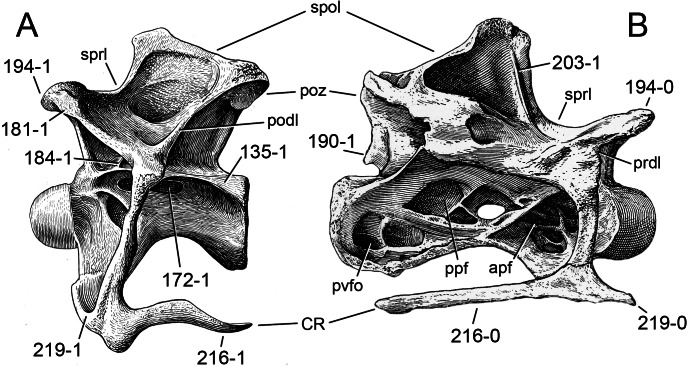
Cervical vertebra 11 of diplodocids.Cervical vertebra 11 of Apatosaurus louisae CM 3018 (A; modified from Gilmore, 1936) and Diplodocus carnegii CM 84 (B; modified from Hatcher, 1901) in left (A) and right (B) lateral view. Note the posteriorly extending posterior centrodiapophyseal lamina in Apatosaurus (A; C135-1), the anteriorly restricted pneumatic foramen typical for most apatosaurs (A; C172-1), the pre-epipophysis (A; C181-1), the subdivided prezygapophyseal centrodiapophyseal fossa, characterizing A. louisae (A; C184-1), the posteriorly expanded interpostzygapophyseal lamina of Diplodocus (B; C190-1), the posteriorly restricted prezygapophysis of A. louisae (A; C194-1), compared to the state in Diplodocus, where it reaches the anterior edge of the condyle (B; C194-0), the vertical accessory spinal lamina marking Diplodocus (B; C203-1), the different positions of the cervical ribs (ventrally projecting, A, C216-1; or level with centrum, B, C216-0), and the absence (A; C219-1) or presence (B; C219-0) of the anterior process of the cervical rib. Vertebrae scaled to same posterior cotyle height. Abb: apf, anterior pneumatic fossa; CR, cervical ribs; podl, postzygodiapophyseal lamina; poz, postzygapophysis; ppf, posterior pneumatic fossa; prdl, prezygodiapophyseal lamina; pvfo, posteroventral fossa; spol, spinopostzygapophyseal lamina; sprl, spinoprezygapophyseal lamina.